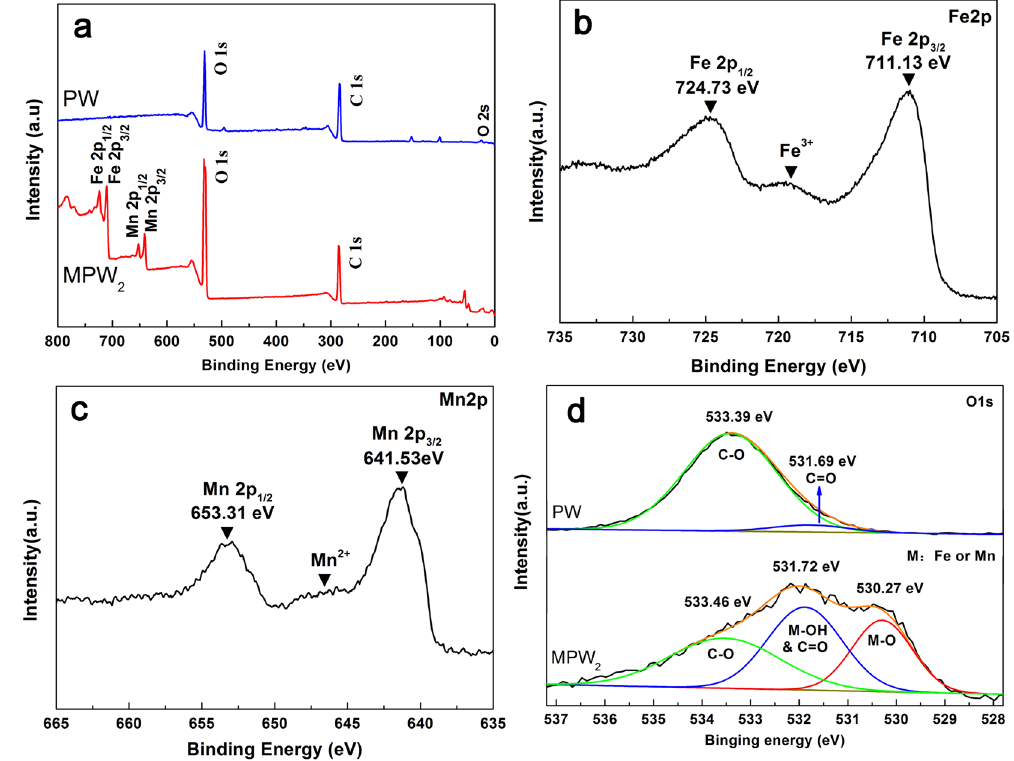
Figure 2. ( a ) Survey-scan XPS spectra of the PW and MPW 2 , ( b ) Fe2p spectra of the MPW 2 , ( c ) Mn2P spectra of the MPW 2 , and ( d ) O1s spectra of the PW and MPW 2